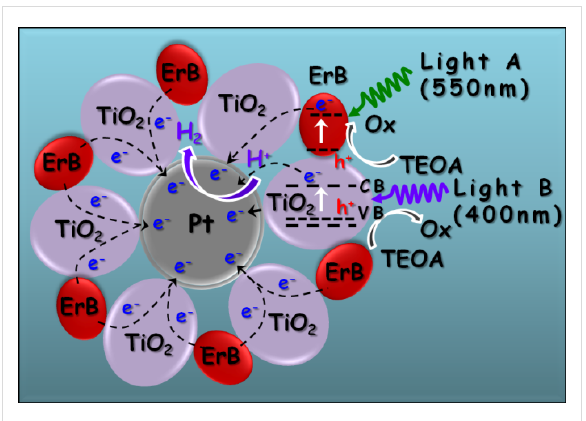
The photocatalytic tests were carried out by suspending the Pt@TiO 2 sample (5 mg) in an aqueous solution containing